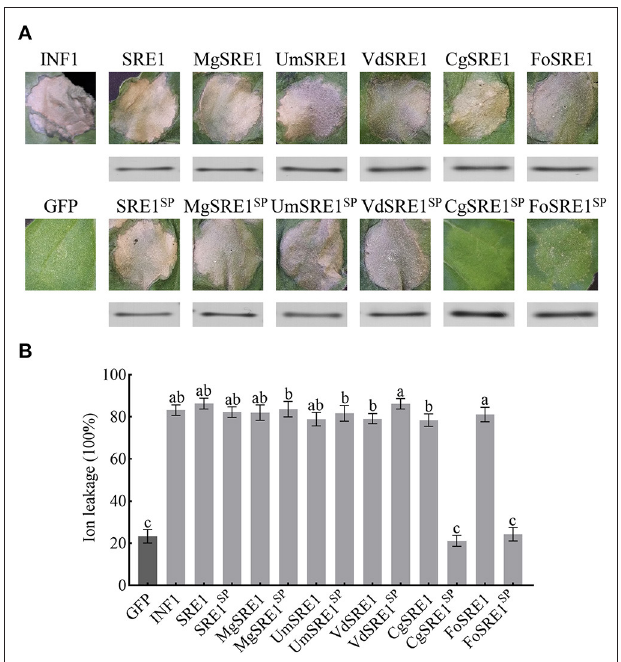
FIGURE 3 | The homologous genes of SRE1 from different pathogenic fungi induces cell death in N. benthamiana. (A) Transient expression of SRE1, SRE1 homologous proteins, and signal peptide deletion mutants in N . benthamiana . INF1 and GFP were used as positive control and negative control, respectively. Western blot analysis of 3 × HA-tagged proteins expressed in N . benthamiana leaves. (B) Quantitative analysis of cell death by electrolyte leakage. The bars are the average of three independent experiments, and the error bars represent the standard deviations. Different letters at the top of the bars indicate significant differences (one-way ANOVA; P < 0.05).